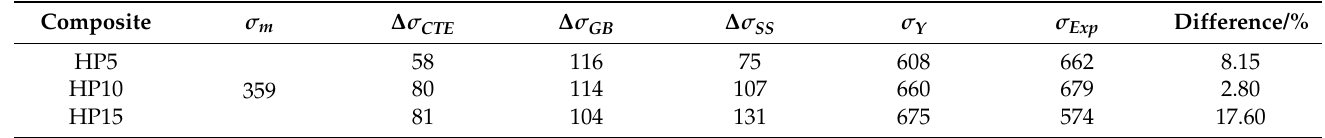
Table 5. Contribution of different strengthening mechanisms in the Ni-20Cr-Eu 2 O 3 composites